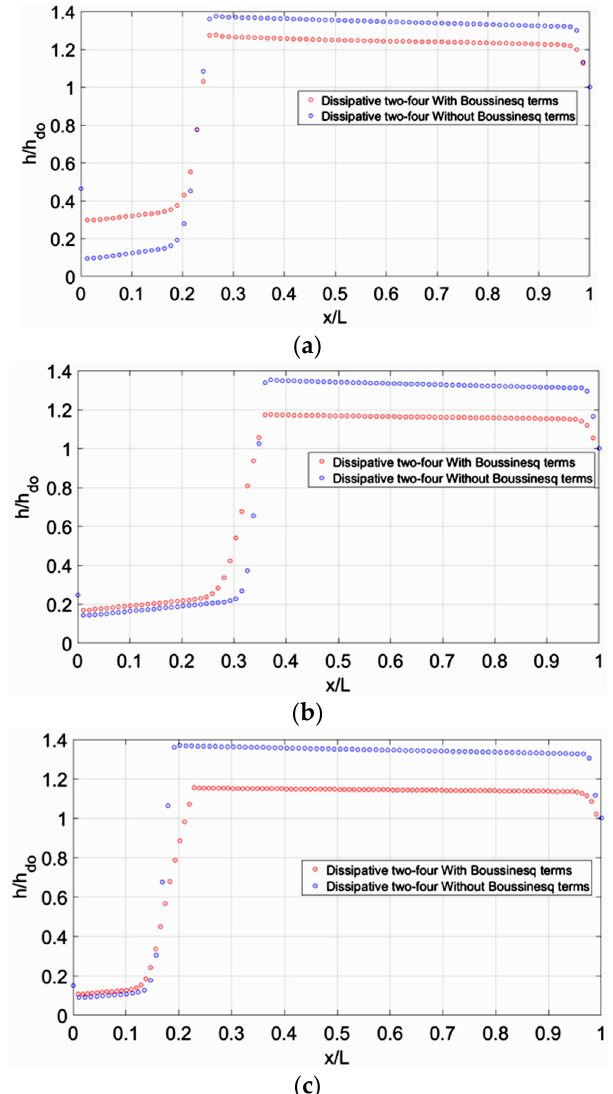
Figure 13. Dimensionless free surface elevation for 5 m wide channel: ( a ) for Fr = 2; ( b ) for Fr = 4; ( c ) for Fr = 6. Table 3. Length of jump for 2 m wide open channel.